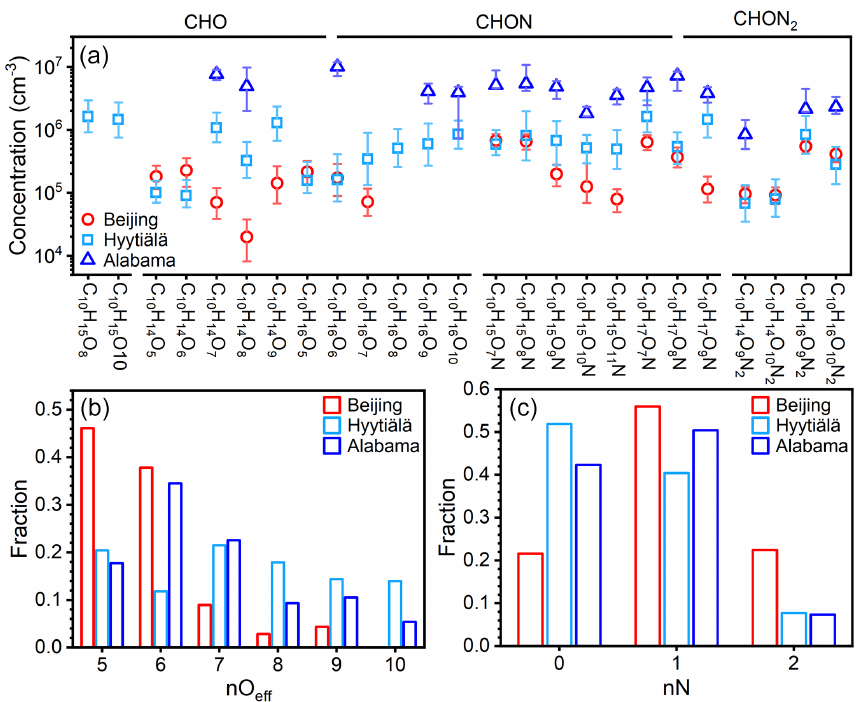
Figure 8. (a) Concentration comparison of specific fingerprint MT OOM molecules between our study and previously reported ones (Massoli et al., 2018; Yan et al., 2016). The markers are median concentration values, and the upper and lower bounds of the error bars denote 25th and 75th percentiles, respectively. Please note that only the summer Beijing data were plotted as the overall pattern of MT OOMs in Beijing summer and spring are very similar (Fig. 7). The distribution of the (b) effective oxygen number, nO eff , and (c) nitrogen number, nN, of MT OOMs is plotted in panel (a)